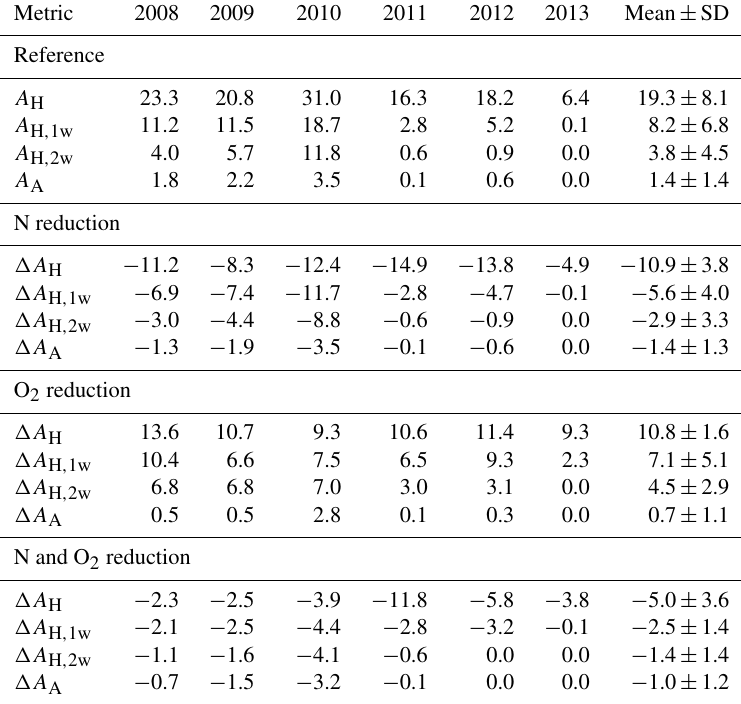
Table 1. Hypoxia metrics for the four different cases presented in Fig. 6. A H : hypoxic area; A H , 1w and A H , 2w : areas with continuous hypoxia for 1 and 2 weeks, respectively; A A : anoxic area (i.e., sum of areas of all grid cells with at least 1d of O 2 = 0mmolm − 3 ; all in 10 3 km 2 ). Values for the reference simulation are total areas. Other values are changes in area ( (cid:49) ) relative to the reference